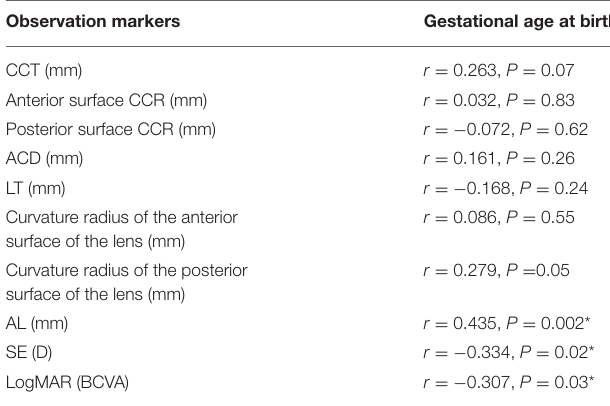
TABLE 5 | Correlations of gestational age at birth with eye biology and refractive status in the laser group. Observation